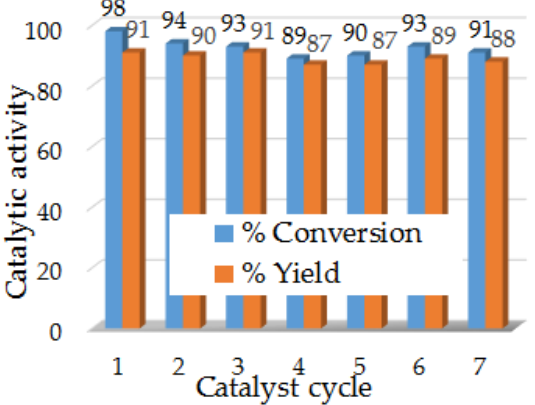
Figure 7. The recyclable catalyst using 9.2 mmol ECH, catalyst Zn/CN (50 mg) at 90 °C, 1 bar CO 2 pressure for 24 h. Conversion and yields (isolated) were determined by 1 H NMR and using 1,3,5-trimethylbenzene as the internal standard.